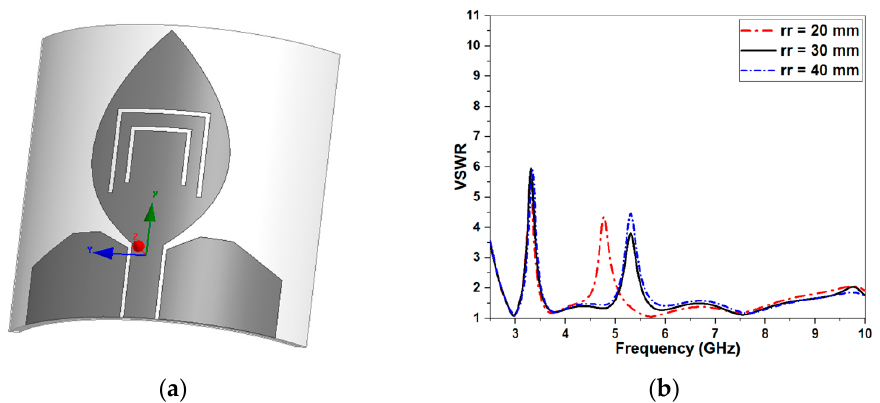
Figure 9. Conformal application: ( a ) conformal antenna; ( b ) effect of radius rr on antenna performance.